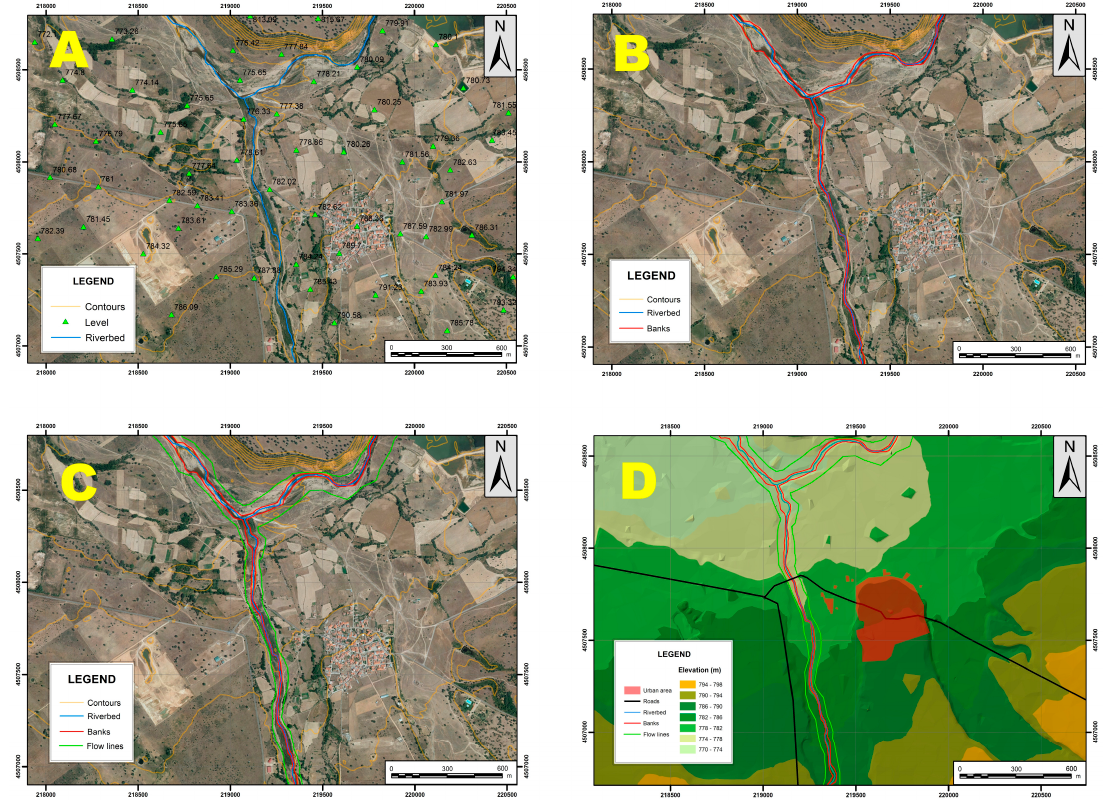
Figure 4. ( A ) Digitalization of the riverbed axis; ( B ) river banks; ( C ) flow lines; and ( D ) the digitalization of all of the longitudinal parameters overlaid on the TIN model.